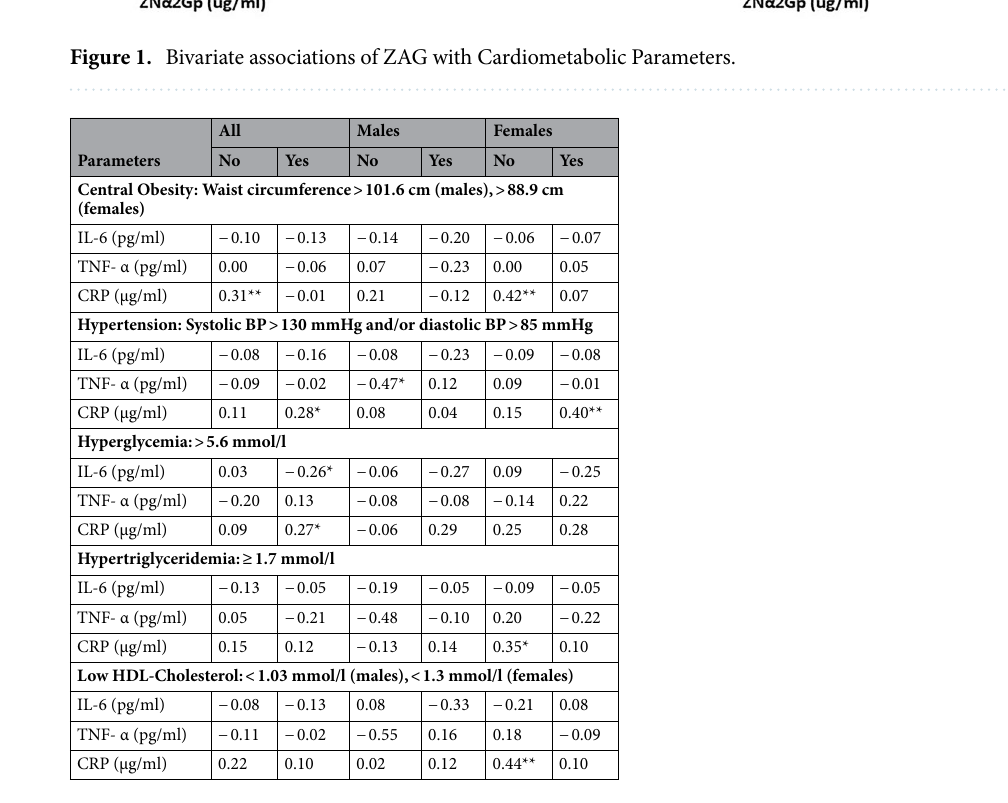
Table 2. Correlation analysis between ZAG (ug/ml) with Proinflammatory Cytokines in association with different metabolic components. Data presented as coefficient (R). *Denotes significance at 0.05 level. **Denotes significance at 0.01